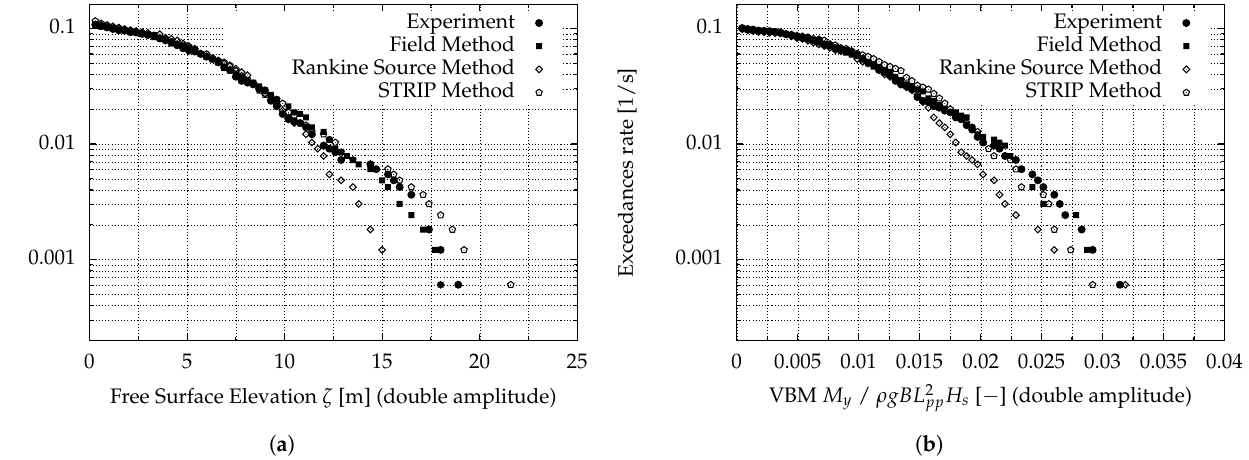
Figure 22. Cruise ship: short-term statistics of ( a ) free surface elevation and ( b ) midship vertical bending